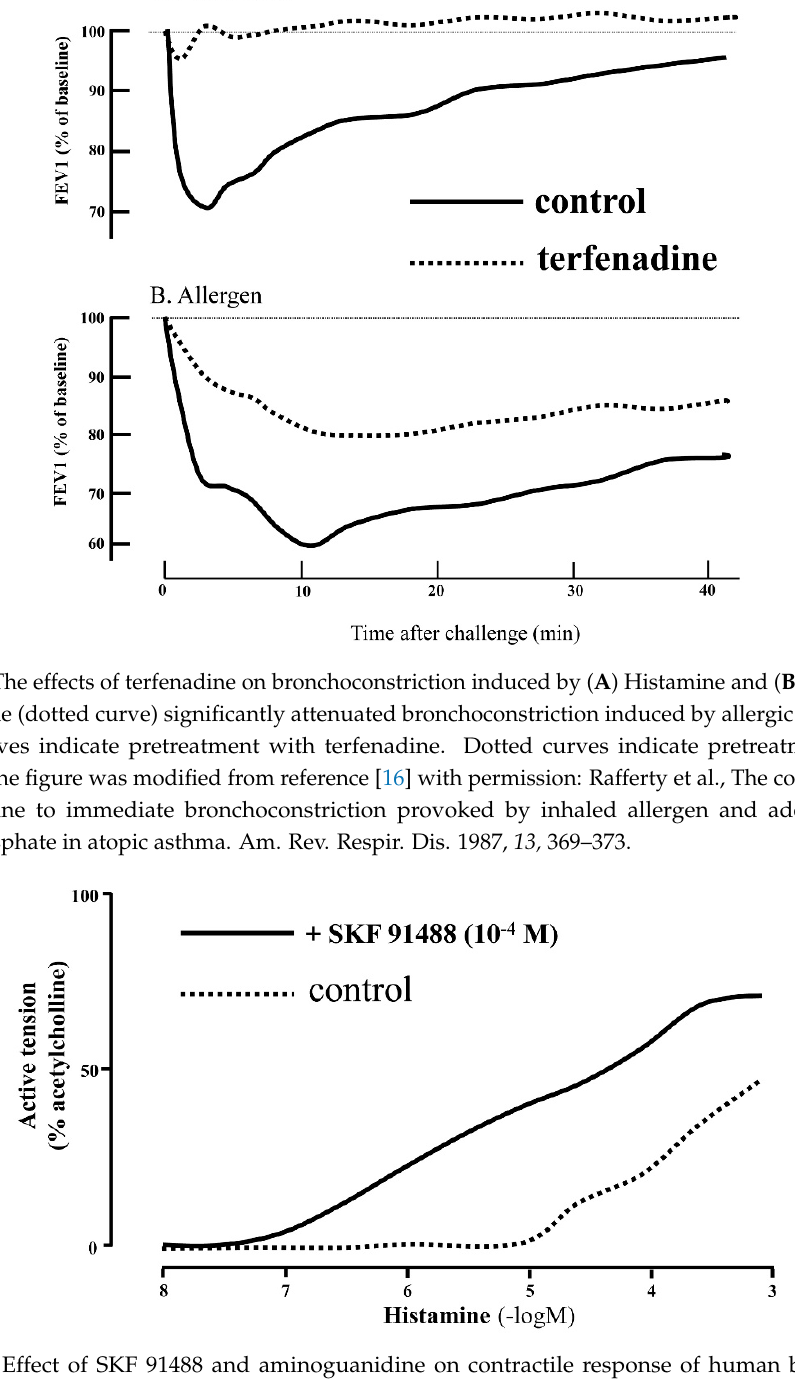
Figure 3. Effect of SKF 91488 and aminoguanidine on contractile response of human bronchi to histamine. Dose–response curves to histamine in SKF 91488 (10 − 4 M) and control are analyzed. Data are expressed as percentage of response to acetylcholine (10 − 3 M). Histamine N-methyltransferase (HMT) regulates contraction of airway smooth muscle by histamine. HMT in epithelium degrades histamine actively. The figure was modified from reference [19] with permission: Yamauchi et al., Structure and function of human histamine N -methyltransferase: critical enzyme in histamine metabolism in airway. Am. J. Physiol. 1994, 267 , L342–L349.